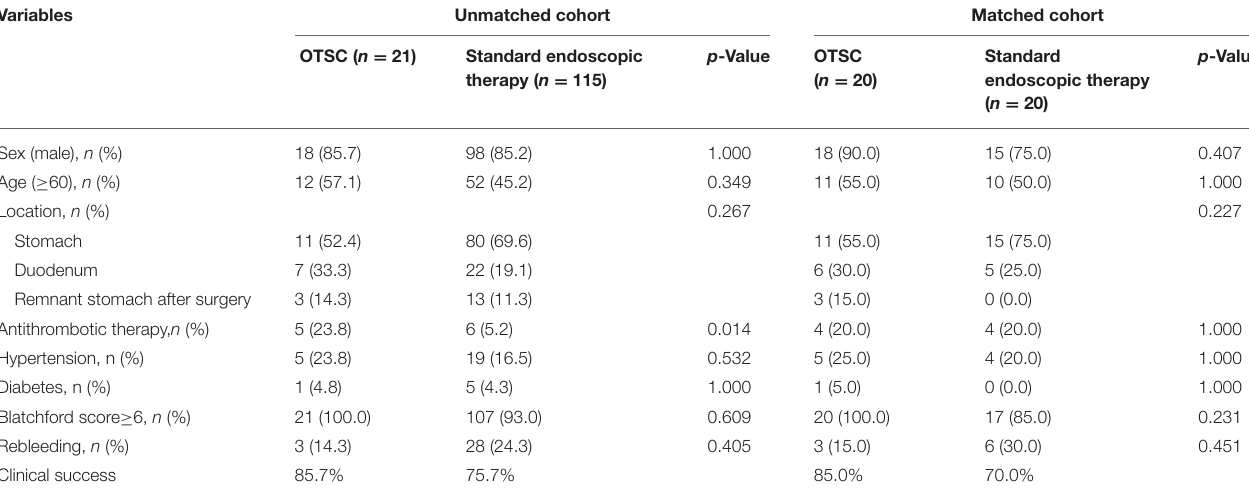
TABLE 3 | Clinical characteristics of the patients with Dieulafoy’s lesion in the unmatched and matched cohorts.